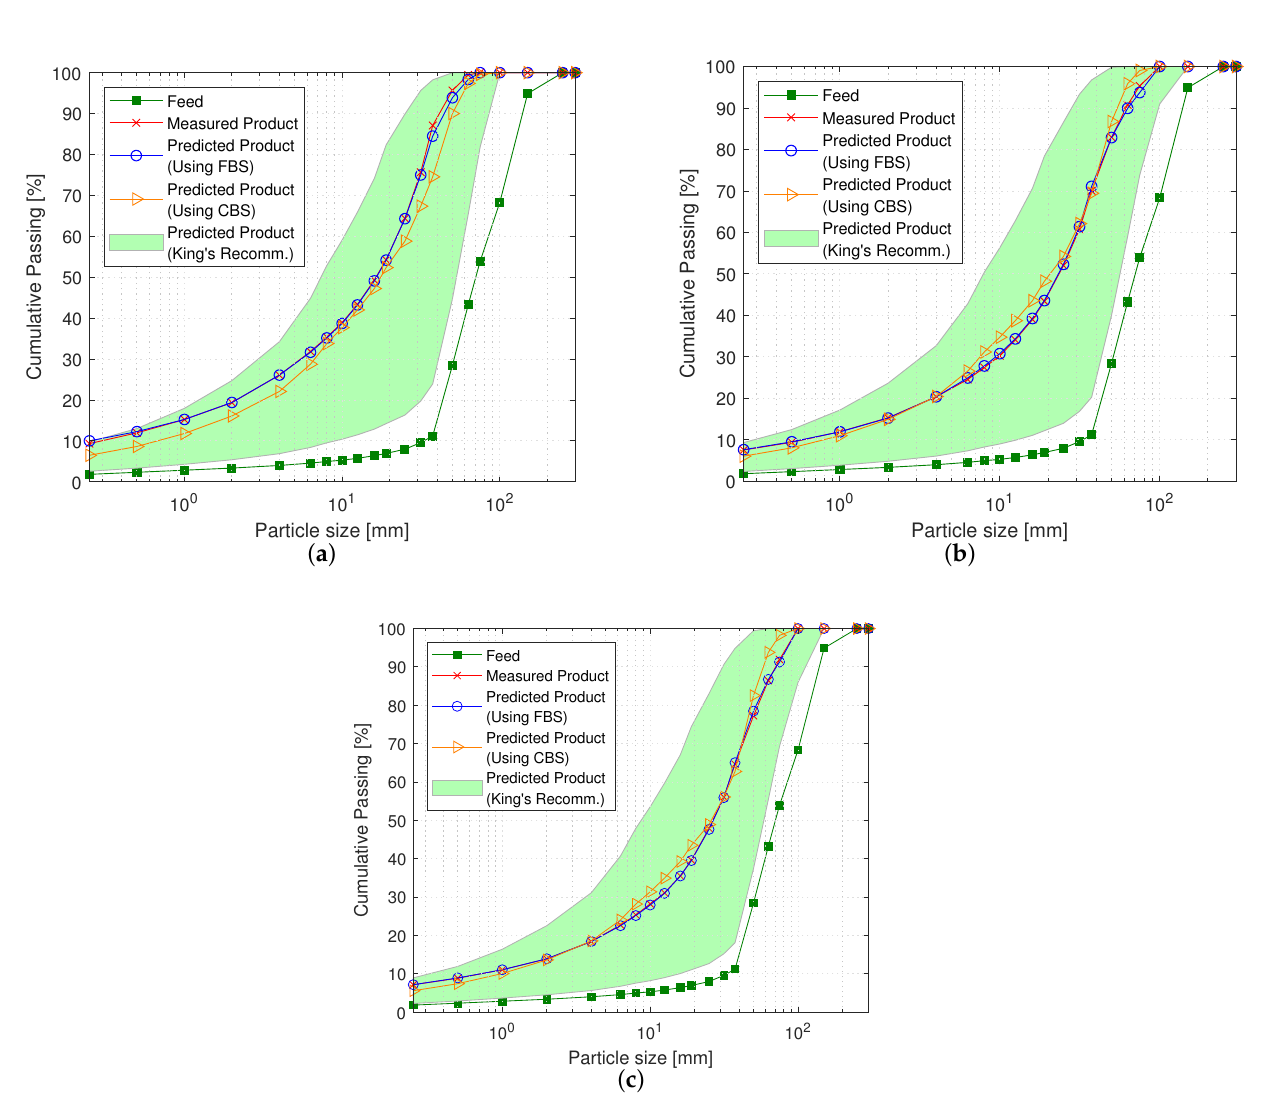
Figure 5. Measured and predicted PSD curves in Scenario 1 for the Serra Leste datasets. ( a ) PSD predicted using the model calibrated on datasets 1, 2 and 3. Validation with Dataset 1. ( b ) PSD predicted using the model calibrated on datasets 1, 2 and 3. Validation with Dataset 2. ( c ) PSD predicted using the model calibrated on datasets 1, 2 and 3. Validation with Dataset